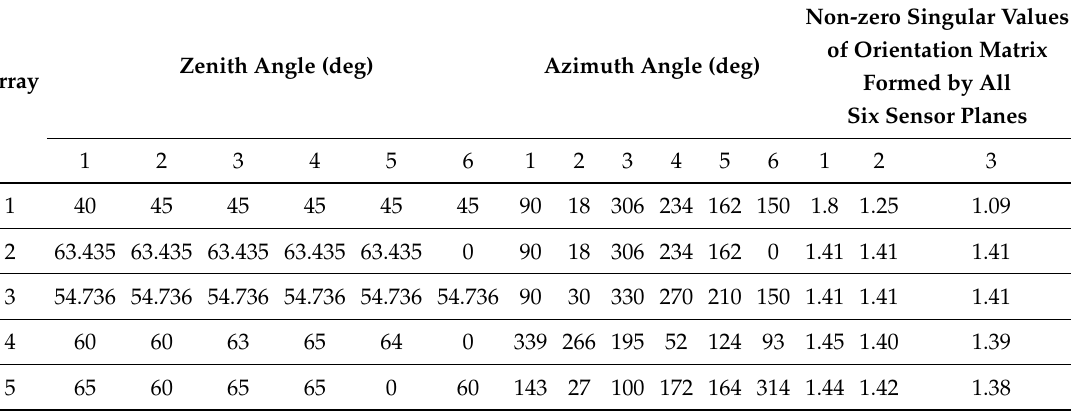
Table 1. Configuration of the selected sensor arrays.